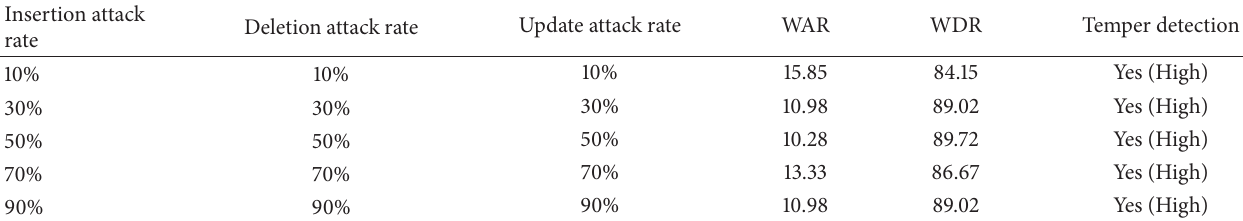
Table 5: Detection of malicious data modifications with different attack rates ( 𝜂 = 10 6 ).